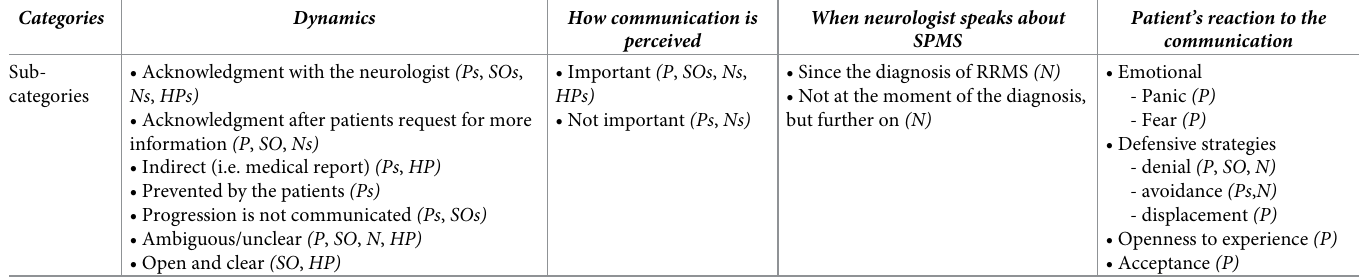
Table 3. Theme 2: Communication of the transition. HP, health professional; MS, multiple sclerosis; N, neurologist; SO, patient significant other; SPMS, secondary pro- gressive multiple sclerosis; RRMS, relapsing remitting multiple